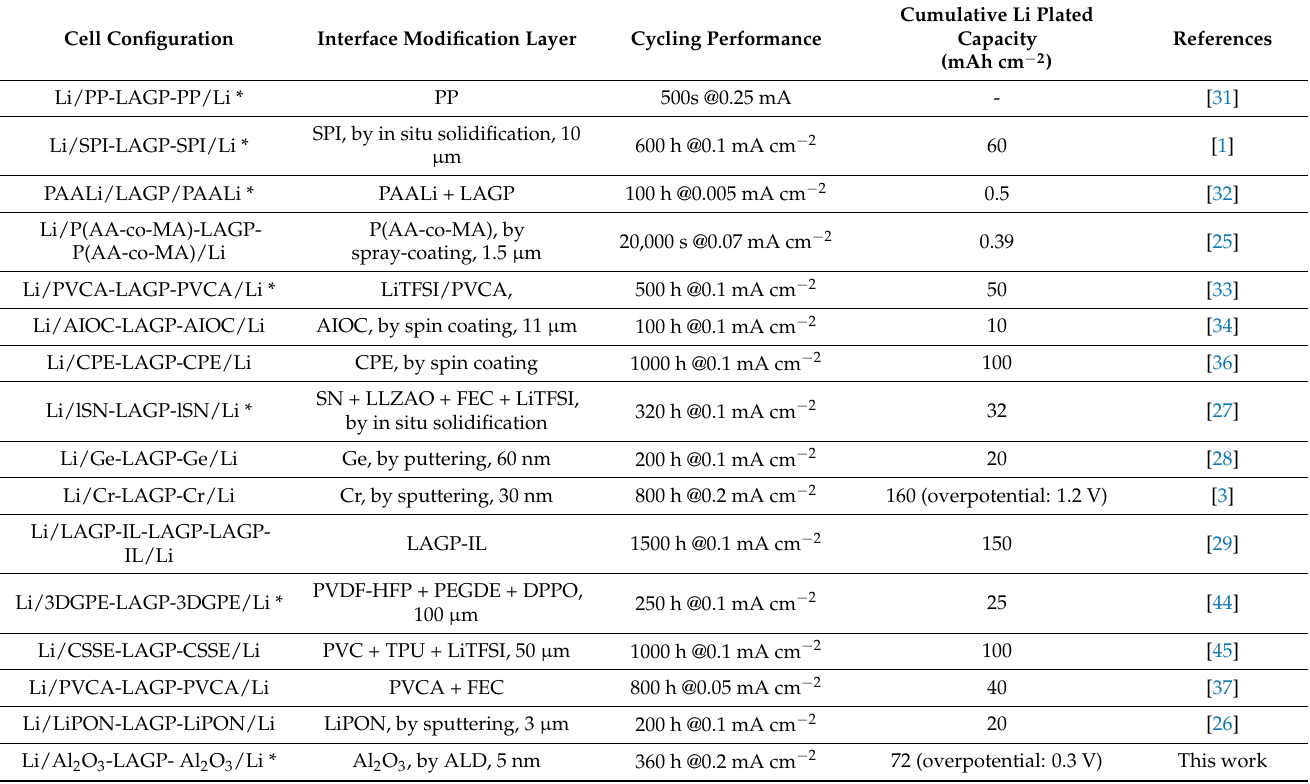
Table 1. Comparison of Li/LAGP/Li cells with interface